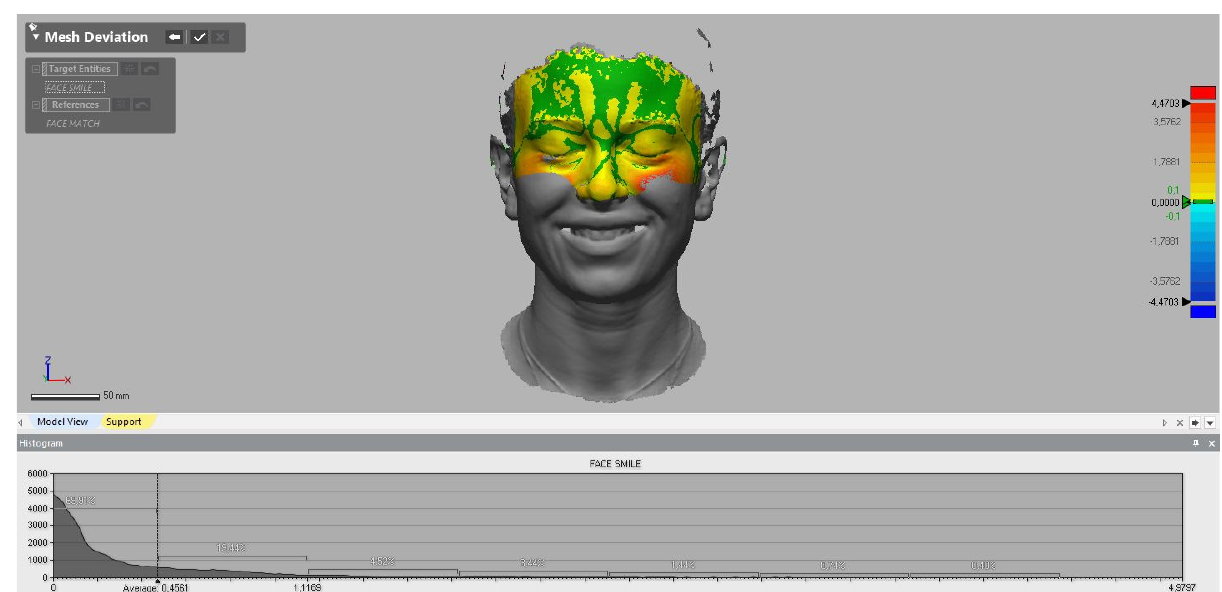
Figure 14. 3D deviation analysis between face scan with lip-and-cheek retractor and face scan with smile. RGB-colored scale bar (millimeters) is reported on the right. Histogram chart is reported at the bottom.